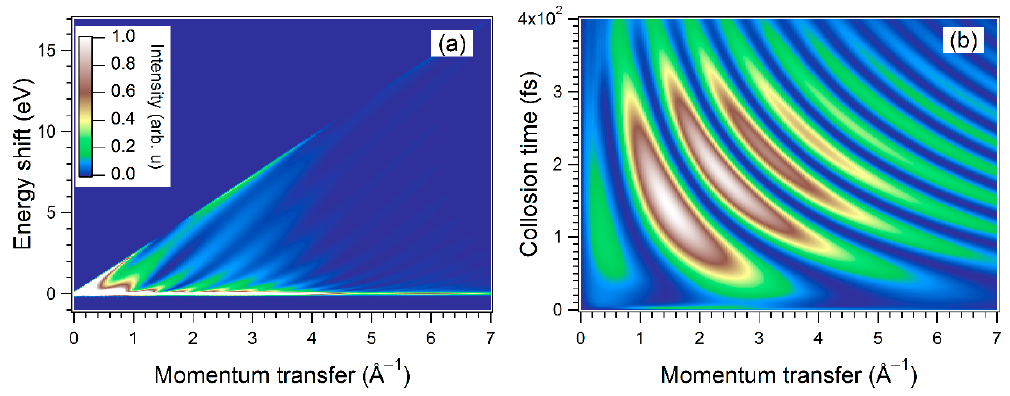
Figure 13. Results of numerical simulations of LAES obtained when 1 keV electrons are scattered by Cl 2 molecules in a single-cycle THz pulse whose peak electric field intensity and peak frequency are 80 kV/cm and 1.0 THz, respectively [11]. ( a ) Calculated signal distributions of electrons scattered by dissociating Cl 2 molecules. ( b ) Time-resolved electron diffraction patterns obtained from the signal distributions shown in ( a ).